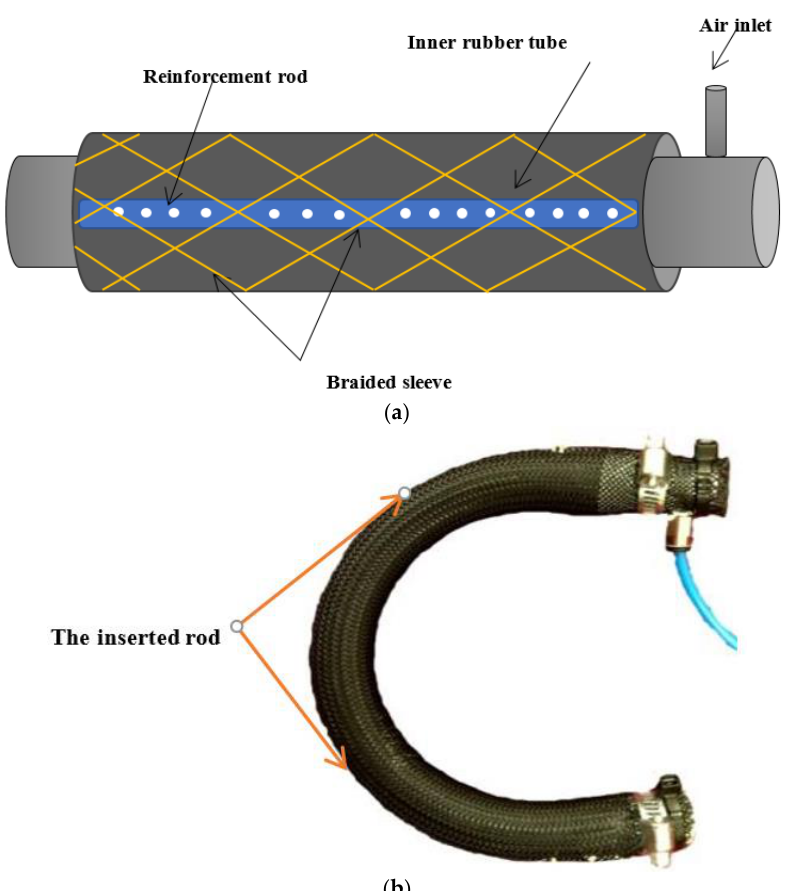
Figure 3. The novel structure of the self-bending contraction actuator (SBCA) version II. ( a ) The structure of the SBCA showing the inserted rod. ( b ) The 30 cm SBCA at 300 kPa. Actuators 2020 , 9 , x FOR PEER REVIEW